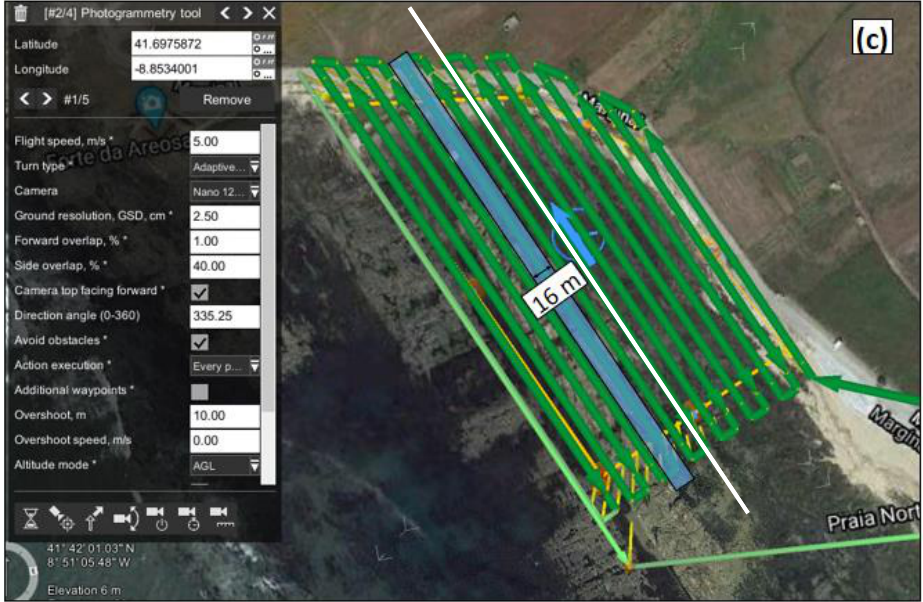
Figure 15. Flight plans, parameters and mission area for the Portuguese study areas: ( a ) Vallado; ( b ) Lousada; and ( c ) Viana. The white dashed lines represent the elevation profile lines.